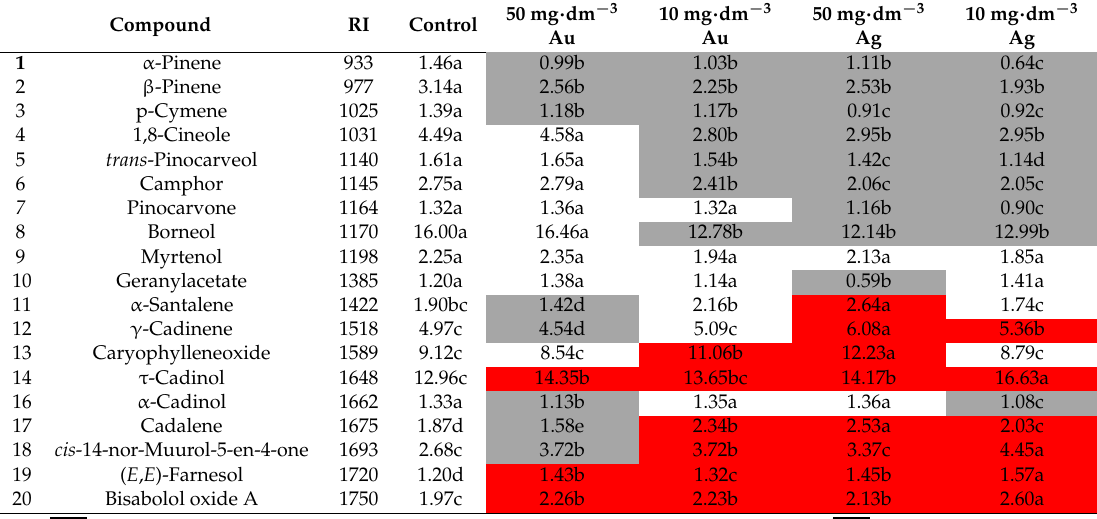
Table 2. Statistical analysis of main compounds.